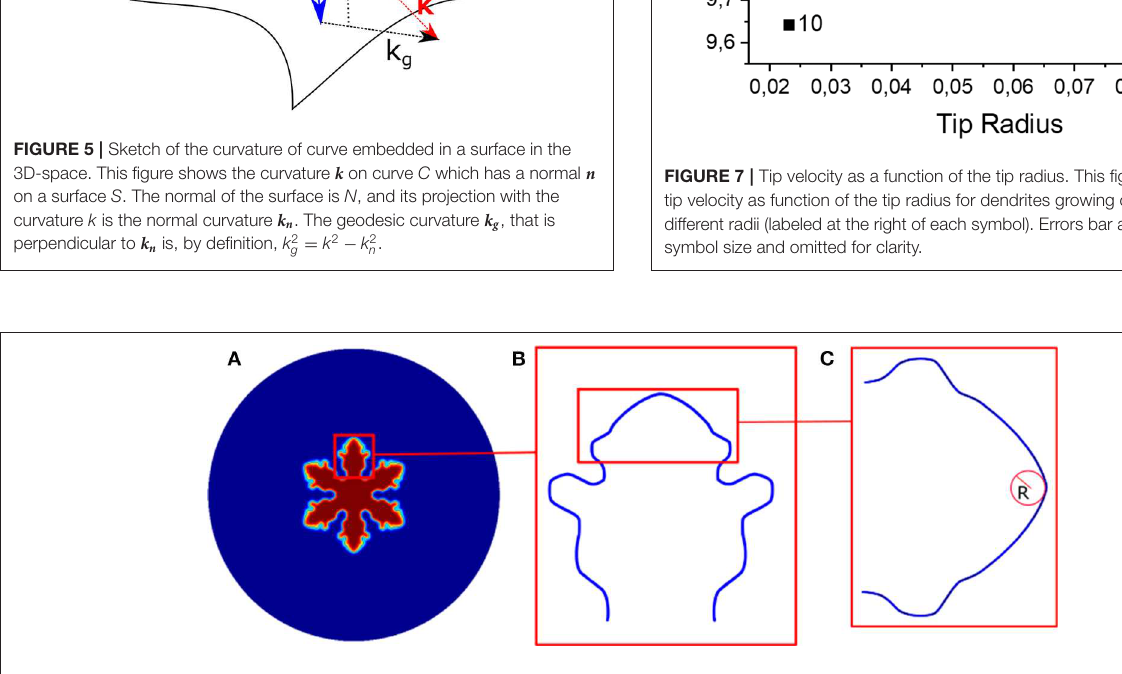
Frontiers in Materials |